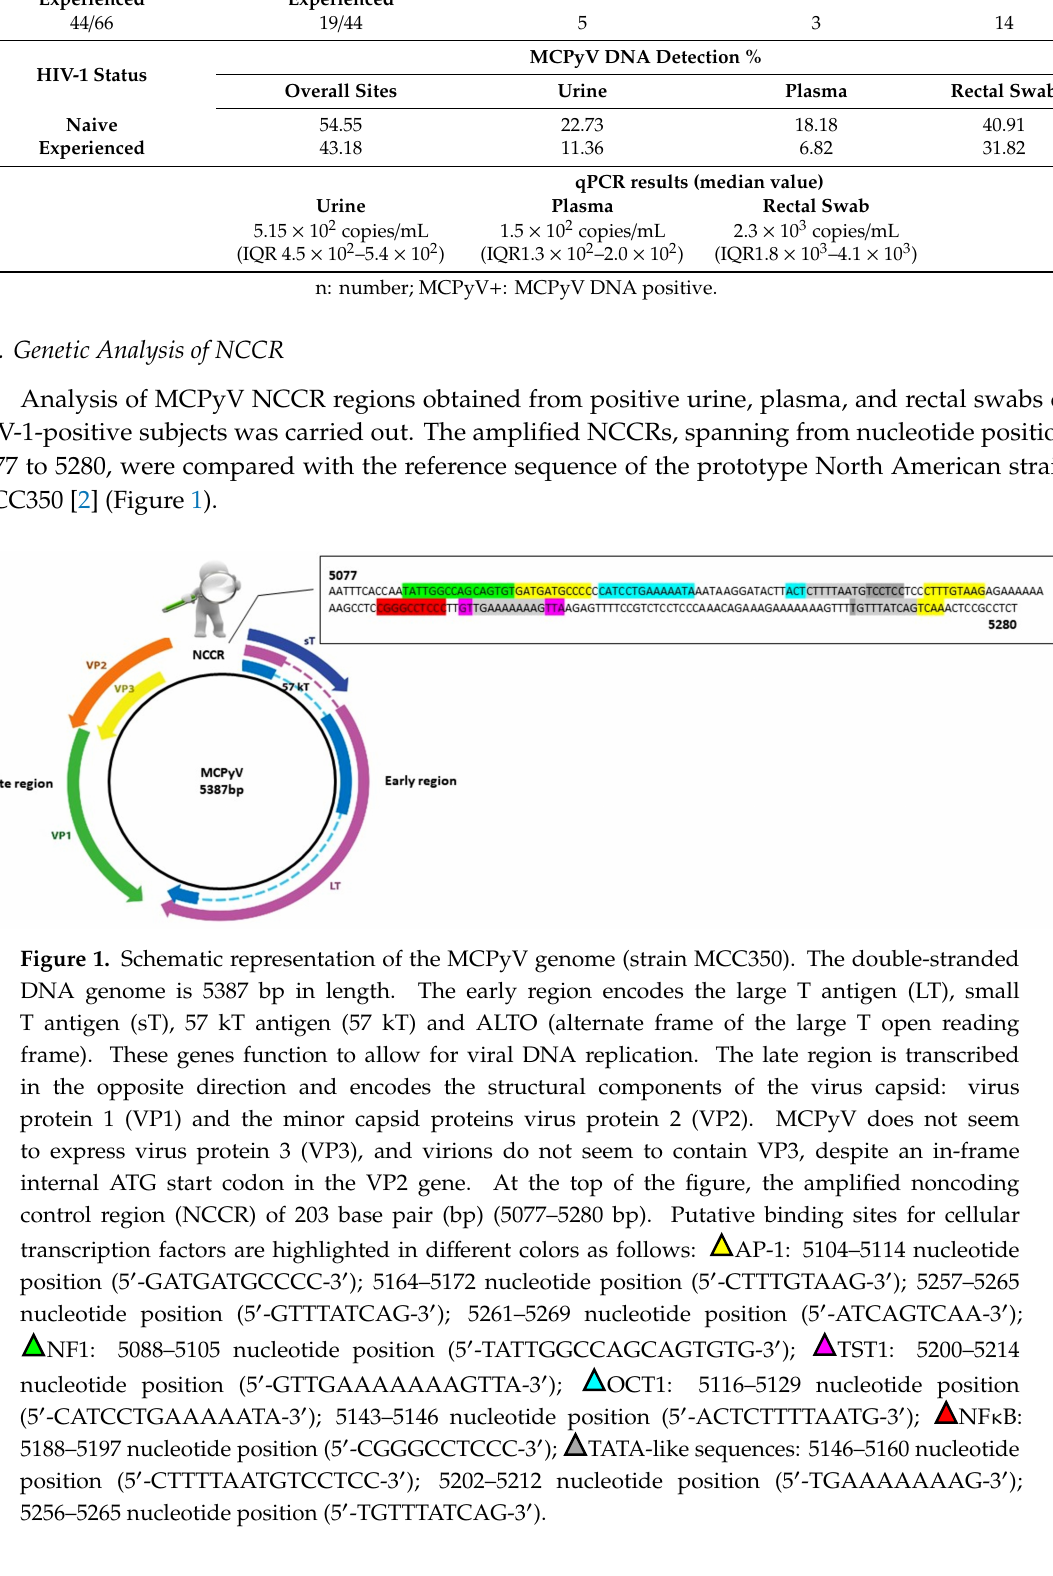
Table 2. Detection and quantification of Merkel cell polyomavirus (MCPyV) DNA by real-time qPCR. HIV-1 Status Patients, n. MCPyV + Patients, n.